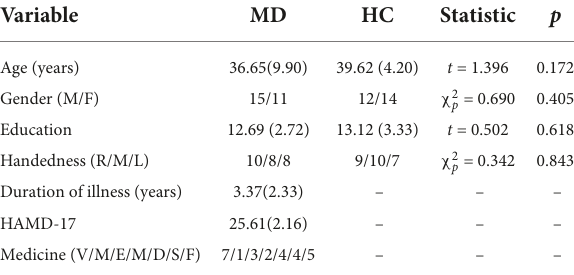
TABLE 1 Demographic and clinical data [mean (SD)] for MD and HC group.